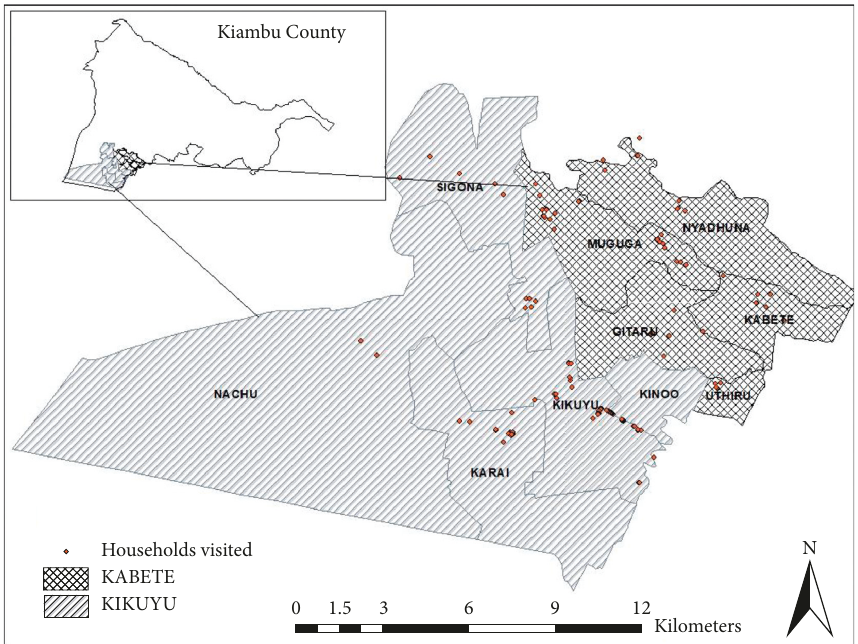
Figure 1: Map of Kiambu County showing the study areas.